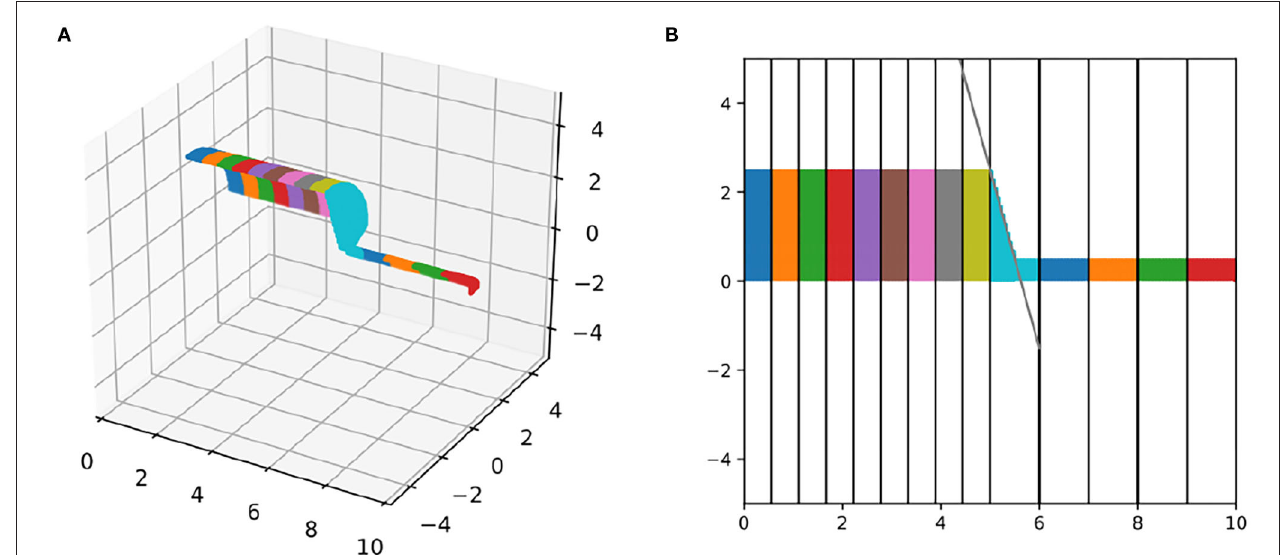
FIGURE 3 | Segment alignment validation. (A) 3D plot and (B) 2D-projection of surface voxels of a morphology with an abrupt change in diameter and a change in segment length, colored by segment. Vertical lines in (B) illustrate the locations of the 1D segment boundaries, which align with the 3D surface nodes. The diagonal black line connects the edge of the last wide segment with the top-middle of the first narrow segment and matches the corresponding 3D cone taper.